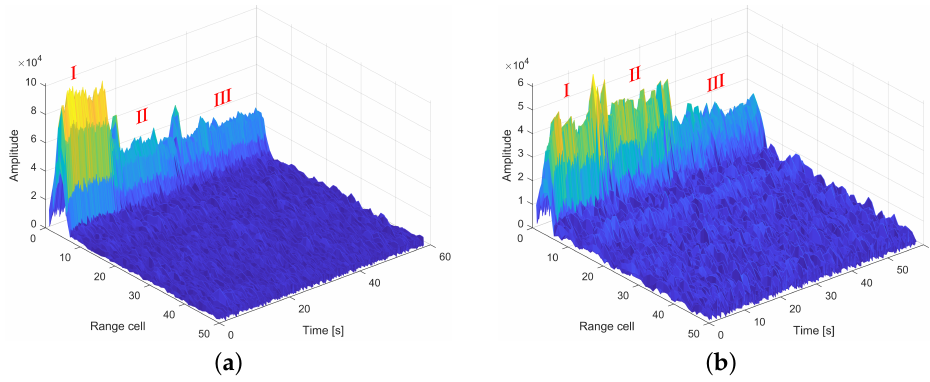
Figure 14. Correlation peak results for dataset 1 ( a ) LHCP1 ( b ) LHCP2.